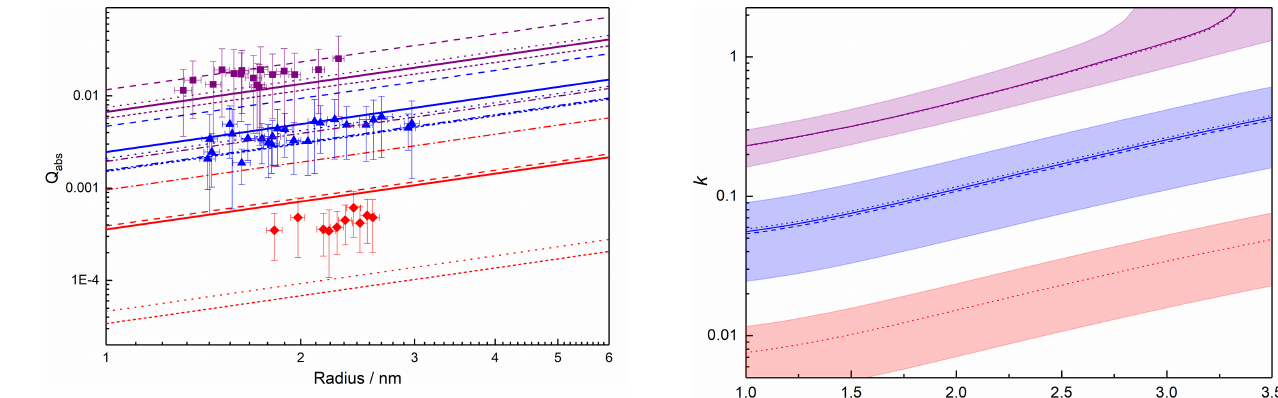
Figure 9. Best-fit RIs k and n for data at 405nm (purple), 488nm (blue) and 660nm (red), for absorption (dotted lines), extinction (dashed lines) and the combination (solid lines). Shaded regions in- dicate where the resulting absorption and extinction cross sections are within experimental error for both